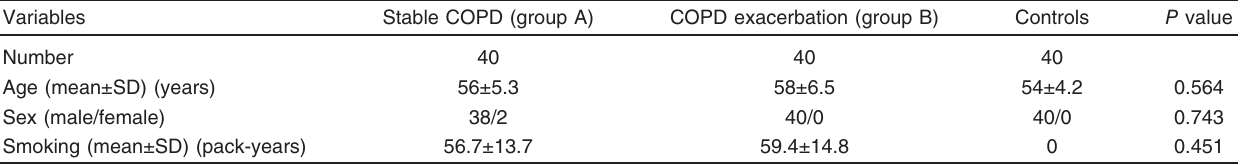
Table 1 Demographic characteristics of COPD patients [stable (group A) and COPD exacerbation (group B)] and controls Variables